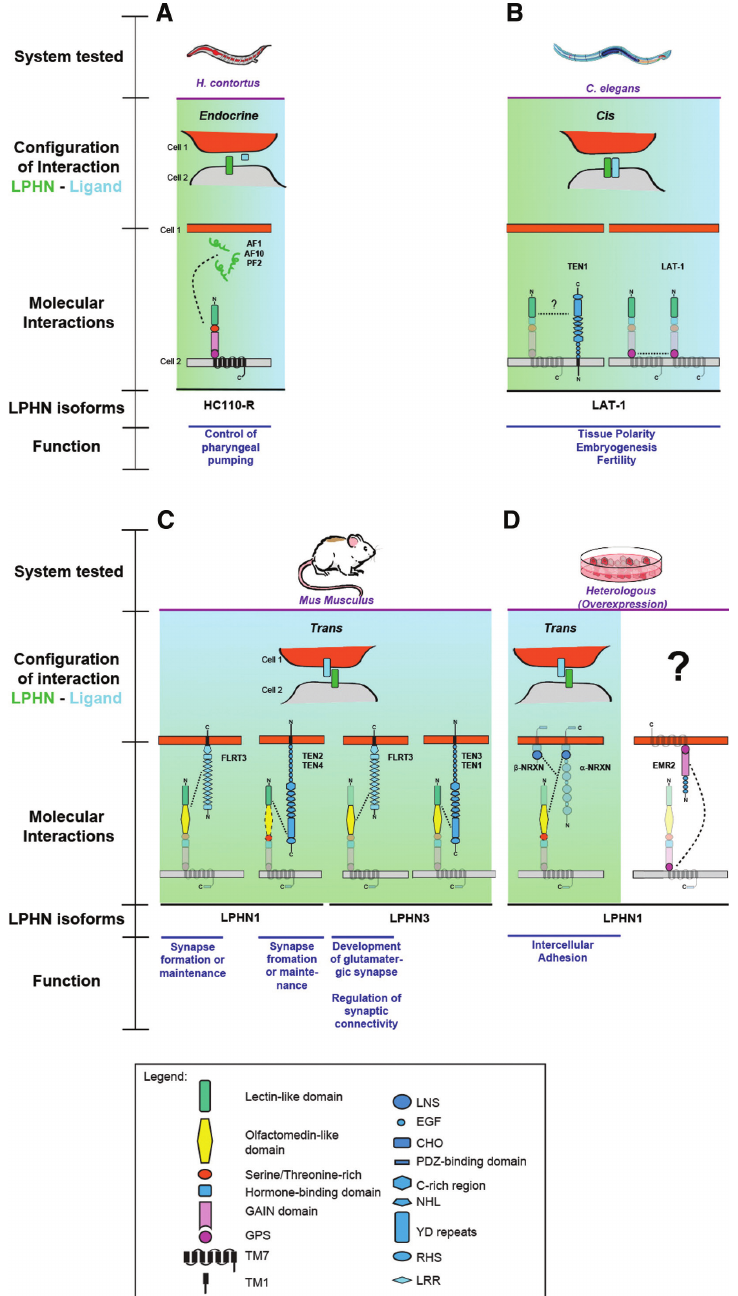
Figure 1 Latrophilins and their endogenous ligands. Represented are molecular interactions involving LPHN and grouped first by systems studied, then binding configuration [Endocrine in (A), cis in (B), trans in (C) and (D), or unknown [?] in (D)], followed by proteins or molecules binding LPHN and finally known functions elicited through LPHN isoforms. Systems studied comprise Haemonchus contortus , C. elegans , Mus musculus , and heterologous cells. Ligands represented are neuropeptides AF1, AF10, PF2 in (A); cis -interacting adhesion molecules TEN1 (teneurin1) and LAT-1 in (B); trans- interacting adhesion molecules FLRT (fibronectin-like domain-containing leucine-rich transmembrane protein), TEN (teneurin), and NRXN (neurexin) in (C) and (D); as well as EMR2 (EGF-like module containing mucin-like hormone receptor-like 2) in (D). Molecular interactions are described for each LPHN domains for the given ligand when known: interacting domains are highlighted in bright color while the remaining of the protein is colored with a transparency level. A dashed line between extracellular domains involved indicates protein-protein interactions. Legends to molecule schematics are shown in detail below. Note that LPHN is represented at the cell-surface of ‘Cell 2’ for clarity purposes in all panels; in no way do we refer to cell specializations like synapses for